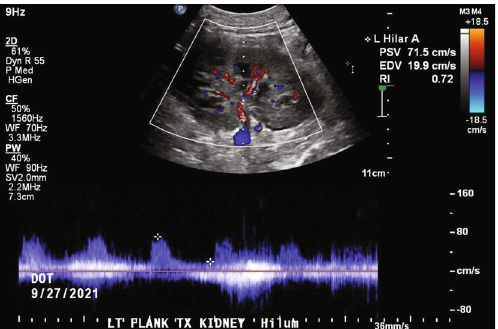
Figure 2: Normal echogenicity and resistive indices of the transplanted kidney as shown by Doppler